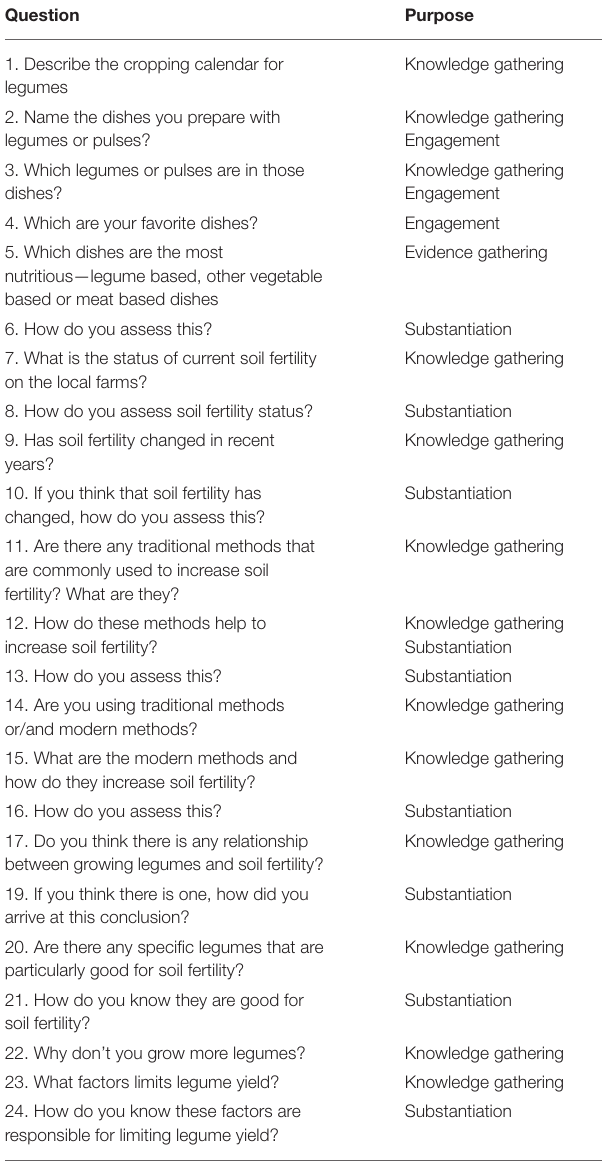
TABLE 2 | Questions used in semi-structured discussions within focus